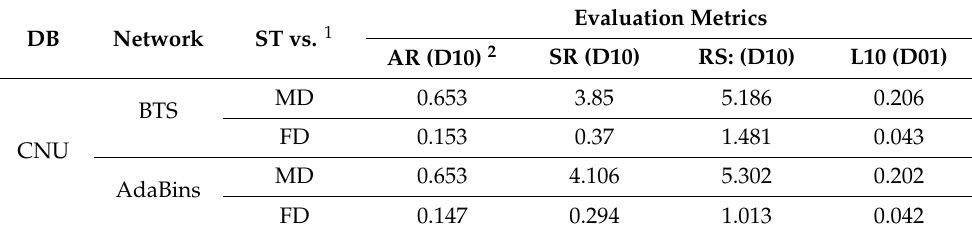
Table 3. Comparison of performances on CNU dataset within 10